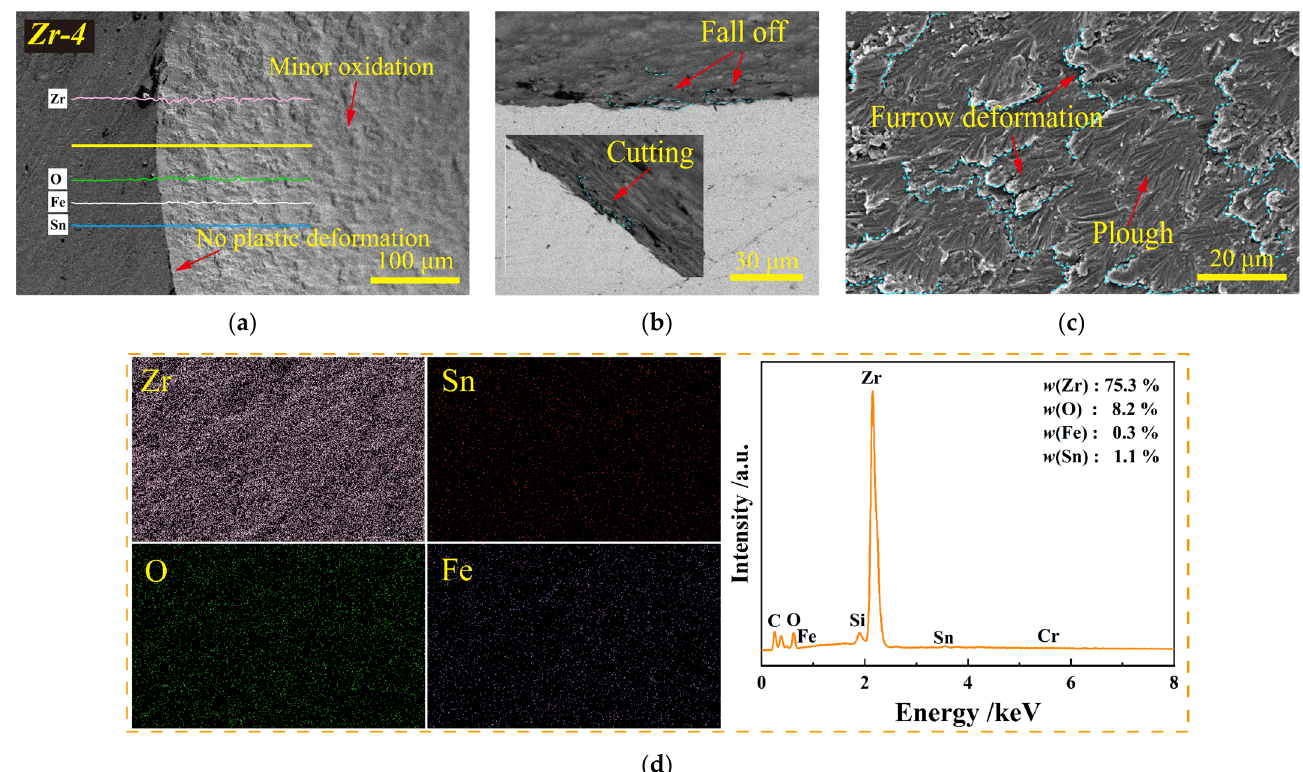
Figure 14. SEM micrographs of wear scar and EDS after being cyclically impacted by Zr−4 impact block 500,000 times. ( a ) Line scan spectrum ;( b ) cross−sectional morphology; ( c ) furrows and plastic deformation; ( d ) wear debris spectrum.